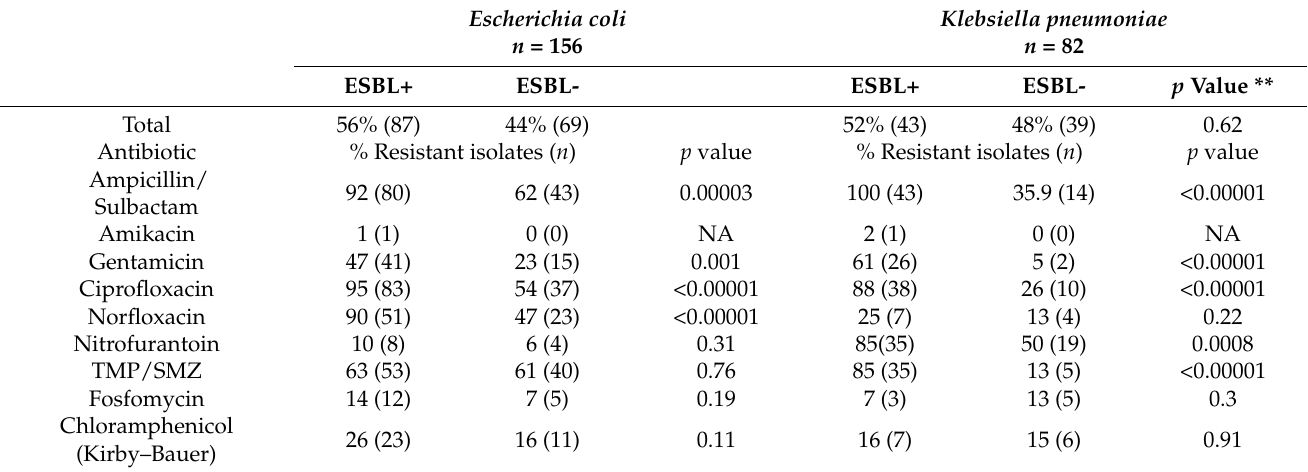
Table 2. Resistance in Escherichia coli and Klebsiella pneumoniae isolates according to ESBL * category.